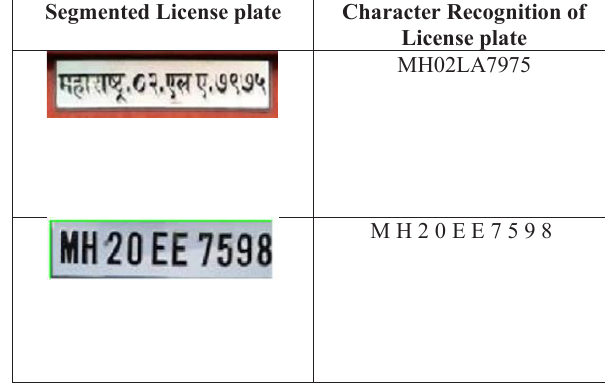
Table 2. Output after performing Optical Character Recognition